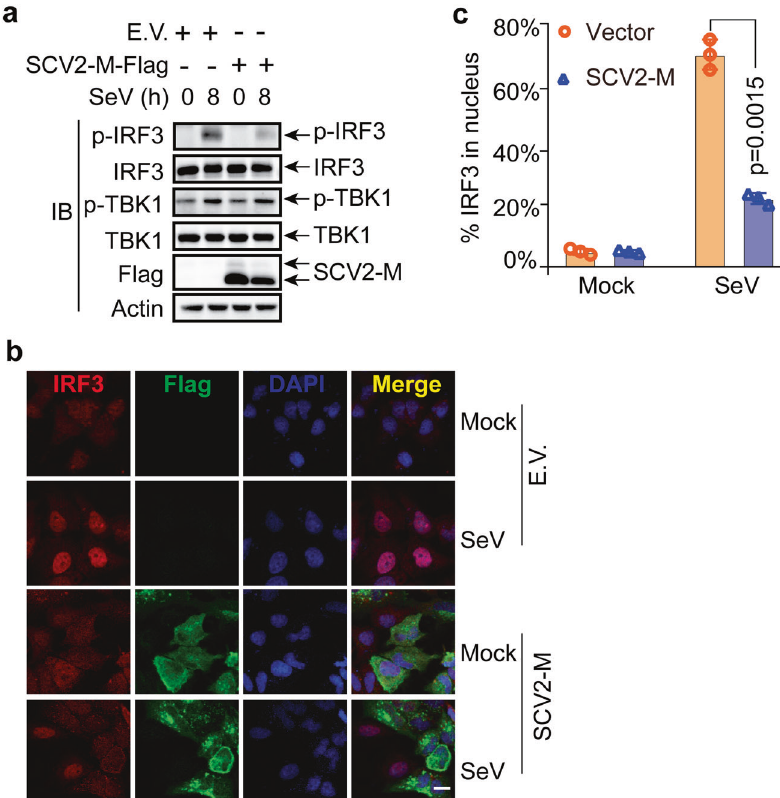
Fig. 6 The SARS-CoV-2 M protein suppresses the phosphorylation and nuclear translocation of IRF3. a The SARS-CoV-2 M protein affects the phosphorylation of IRF3 upon SeV infection. HeLa cells seeded in six-well plates were transfected with the empty vector or Flag-tagged SARS- CoV-2 M protein plasmids for 20 h before infection with SeV (50 HA/mL). At the indicated time points, the cells were harvested and processed for immunoblotting with the indicated antibodies. b The SARS-CoV-2 M protein prevents the nuclear translocation of IRF3. HeLa cells seeded on coverslips in 12-well plates were transfected with the Flag empty vector or Flag-tagged SARS-CoV-2 M protein plasmids for 20 h before infection with SeV. After infection for 8 h, the coverslips were removed and processed for immuno fl uorescence staining with the mouse anti- Flag antibody and a rabbit anti-IRF3 antibody. Scale bar, 10 μ m. c Quanti fi cation of the percentage of IRF3 in the nucleus upon SeV infection. IRF3 molecules in the nuclei in 50 cells per group were counted, and percentages were calculated. Experiments were performed in triplicate and calculated as the means ± SD. Immunoblotting ( a ) and confocal imaging ( b ) results are representative of two independent experiments. Empty vector EV, SARS-CoV-2 M protein SCV2-M, hours